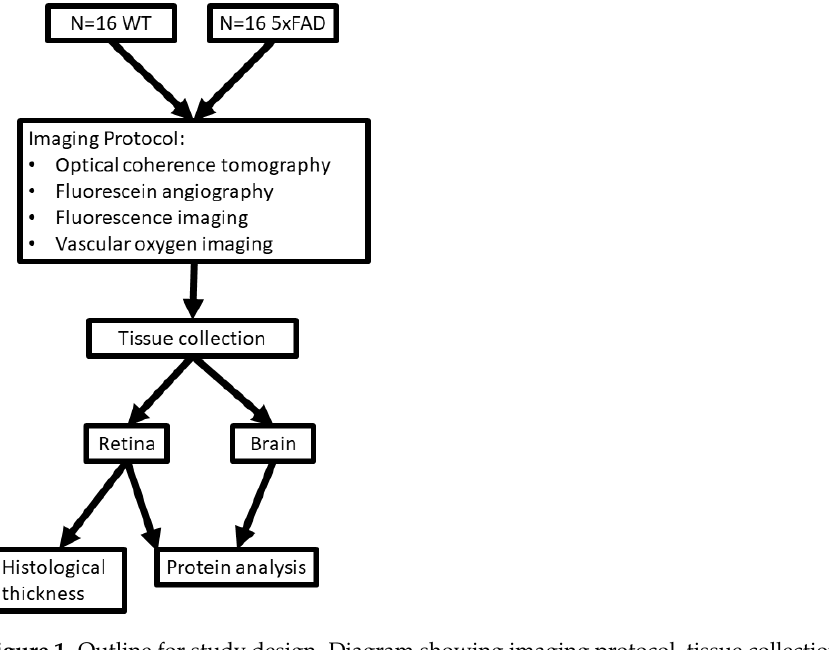
Figure 1. Outline for study design. Diagram showing imaging protocol, tissue collection, and pro- analysis for wild-type (WT) and five-familial Alzheimer’s disease (5XFAD) tein analysis for wild-type (WT) and five- familial Alzheimer’s disease (5XFAD) groups.